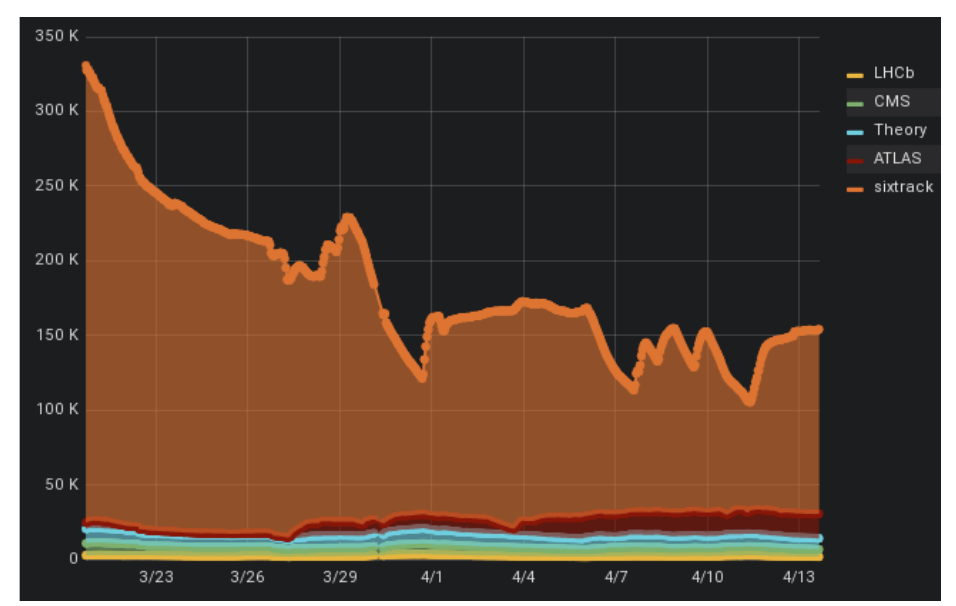
Figure 3. Increase of ATLAS jobs following storage